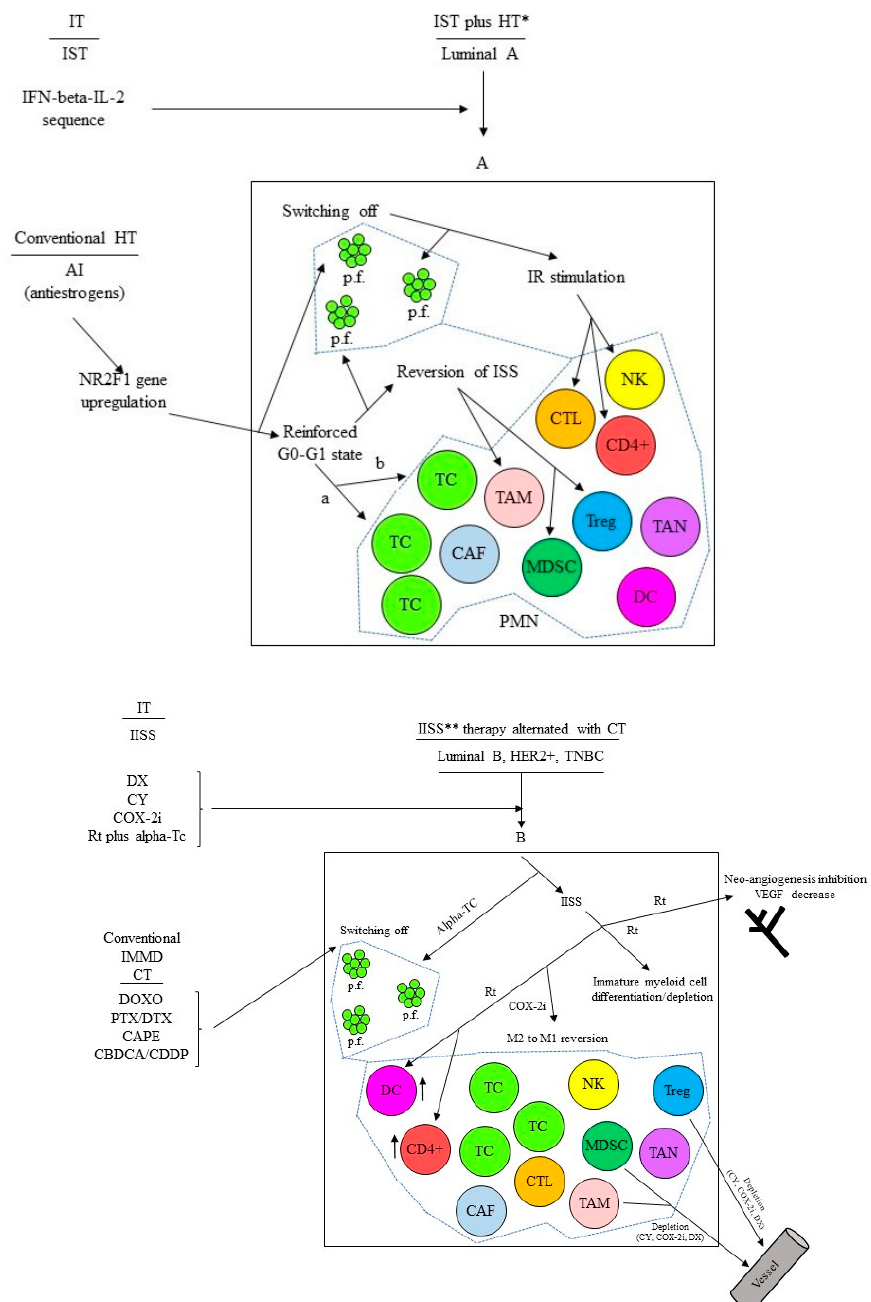
Figure 2. ( A ) Additional cyclic immunotherapy (IT) concomitant with prolonged conventional hormone therapy (HT) in luminal A breast cancer at high risk of relapse. * For the schedule see references [143,145]. IST: immunostimulating therapy; IR: immune response; ISS: immune suppression; IFN: interferon; IL-2: interleukin-2; AI: aromatase inhibitor; a: population-level dormancy model; b: cellular dormancy model; PMN: pre-metastatic niche; p.f.: proliferation focus; PMN borders. ( B ) Additional cyclic immunotherapy (IT) alternated with prolonged conventional adjuvant chemotherapy (CT) in breast cancer other than luminal A and at high risk of relapse. IISS: inhibiting immune suppression; IMMD CT: immune modulatory CT. ** For the schedule see reference [191], this IISS therapy is alternated with four cycles (3 months overall) of conventional IMMD CT; DX: desamethasone; CY: cyclophosphamide; COX-2i: COX-2 inhibitor; Rt: retinyl palmitate; alpha-Tc: alpha tocopheryl acetate; DOXO: doxorubicin; PTX/DX: paclitaxel/docetaxel; CAPE: capecitabine; CBDCA/CDDP: carboplatin/cisplatin; PMN